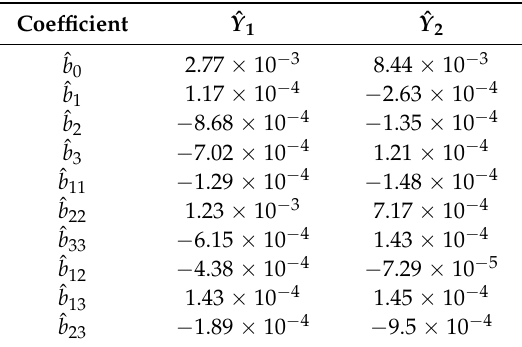
Table 4. Estimated coefficients for Ŷ 1 and Ŷ 2 quadratic models.